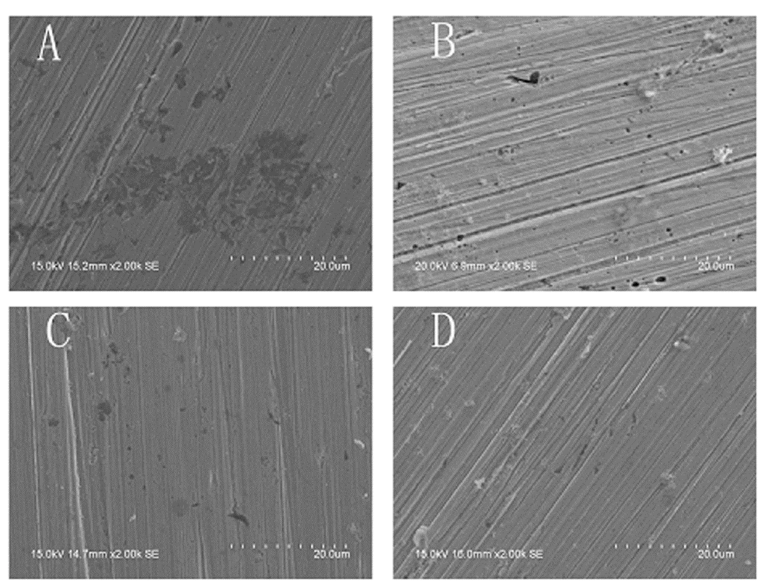
Figure 6. The SECM images of the X70 carbon steel electrodes polarized at − 0.080 V ( E OCP = − 0.330 V) in 0.10 mol/L NaCl + x mol/L NaNO 2 solutions ( A1 – E1 ) x = 0.020; ( A2 – E2 ) x = 0.040; ( A3 – E3 ) x = 0.060; ( A4 – E4 ) x = 0.080.